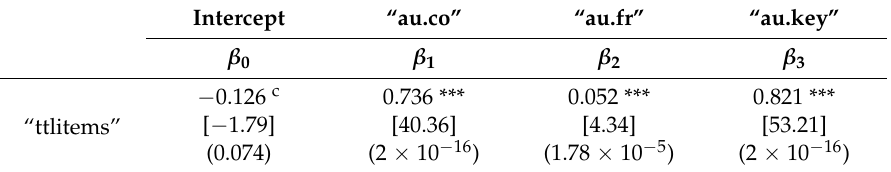
Table 3. Estimation results of “ttlitems” as influenced by “au.co”, “au.fr” and “au.key”. Intercept “au.co” “au.fr” “au.key” β 0 β 1 β 2 β 3 − 0.126 “ttlitems”